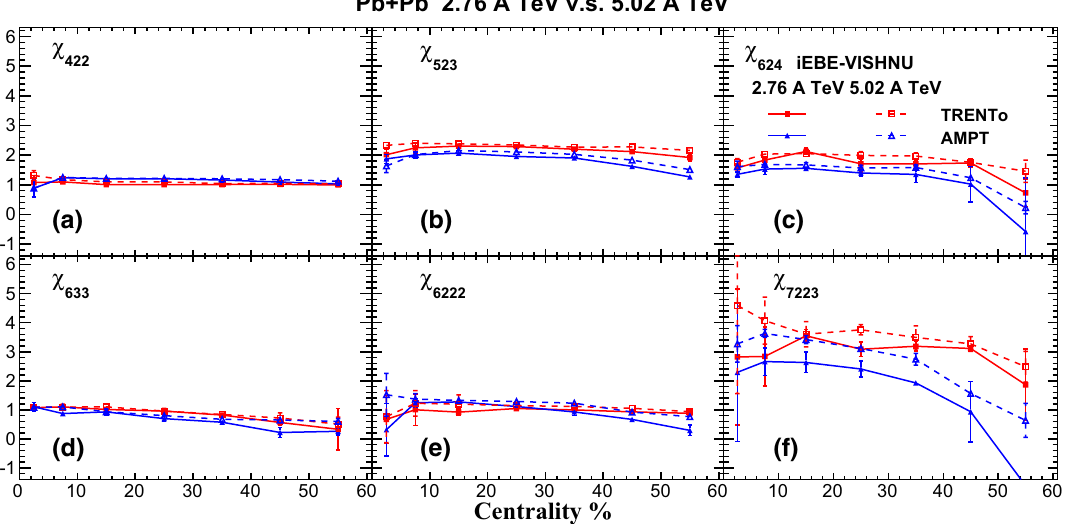
Fig. 10 iEBE-VISHNU predictions for the centrality dependence of the non-linear response coefficients in 2.76 and 5.02 A TeV Pb + Pb